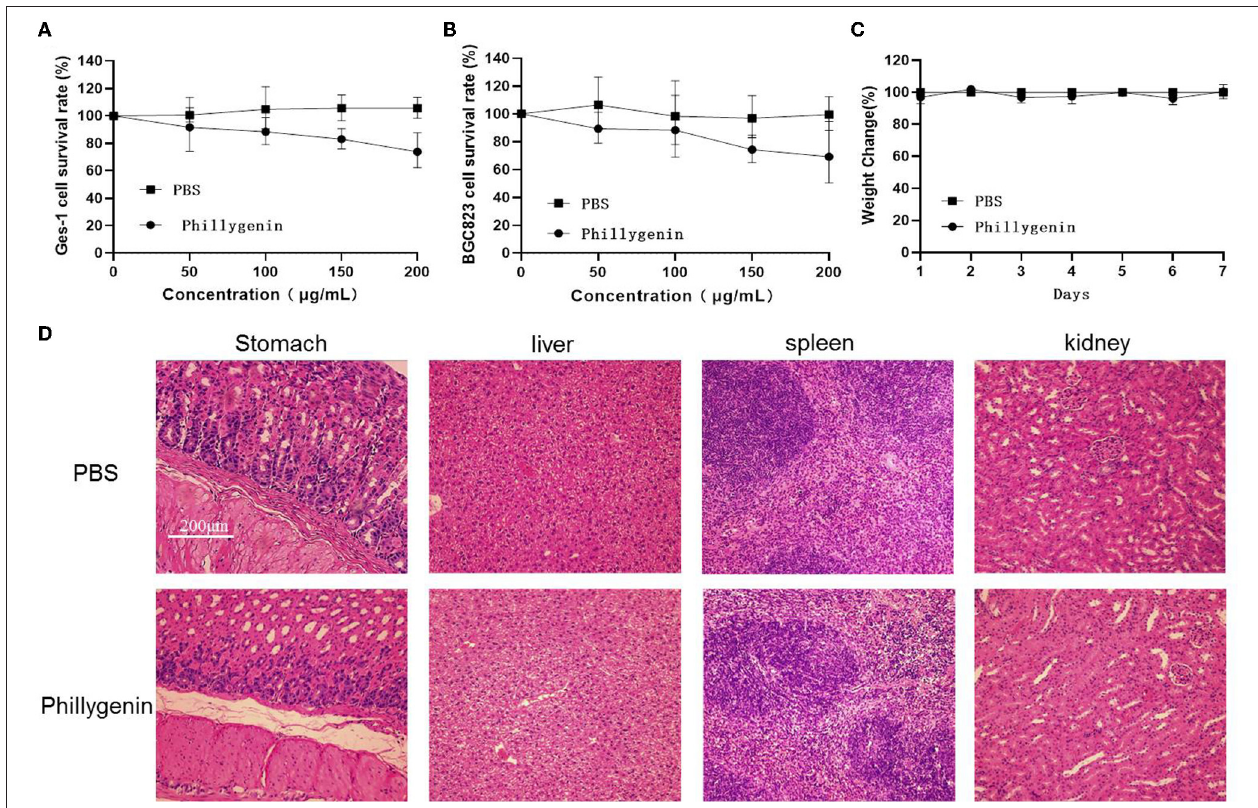
FIGURE 4 | Phillygenin toxicity test. (A) The phillygenin toxicity test for gastric epithelial cell (GES)-1 cells; (B) the phillygenin cytotoxicity test for BGC823; (C) the effect of phillygenin on the weights of mice; and (D) the detection of the damage of phillygenin to stomachs, livers, spleens, and kidneys in